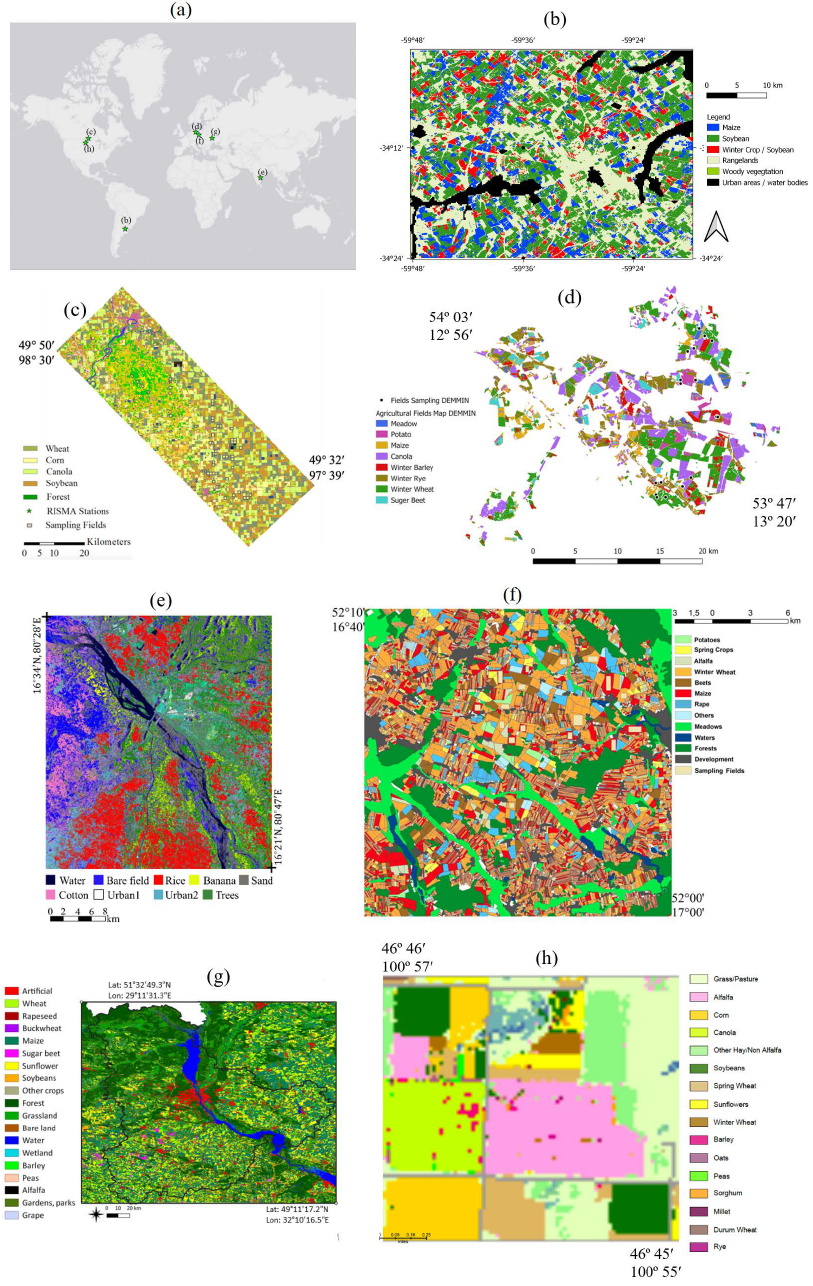
Figure 1. Locations of the Joint Experiment for Crop Assessment and Monitoring (JECAM) sites contributing to this research in ( a ) a world map, and land cover of each site including ( b ) Argentina, ( c ) Canada, ( d ) Germany, ( e ) India, ( f ) Poland, ( g ) Ukraine and ( h ) USA-North Dakota (ND). The white polygons are the boundaries of the test